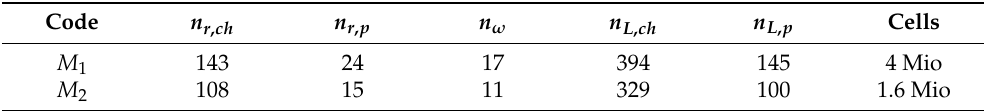
Table 3. Numerical grid parameters. n is the number of divisions, the subindex ch stands for chamber, p for pipe, r for radial, and L for axial